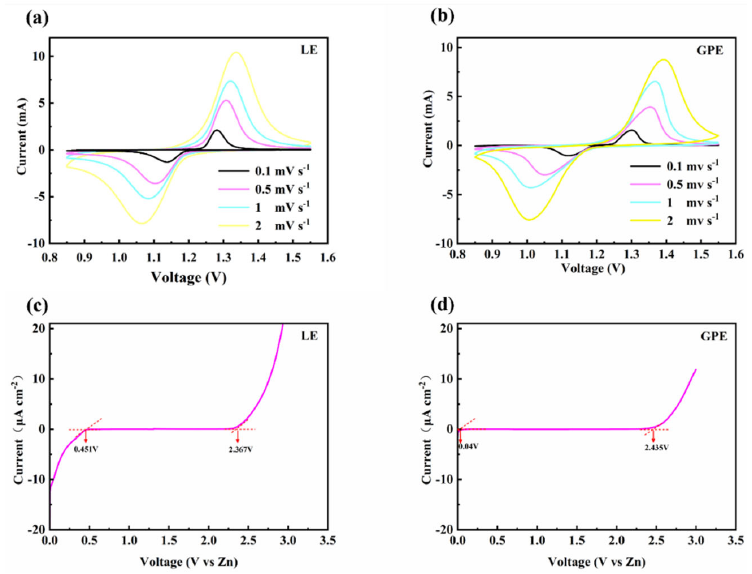
Figure 6. CV curves of ( a ) Zn/LE/LFP and ( b ) Zn/GPE/LFP at different scan rates; the electrochemical stability windows of ( c ) LE and ( d ) GPE.